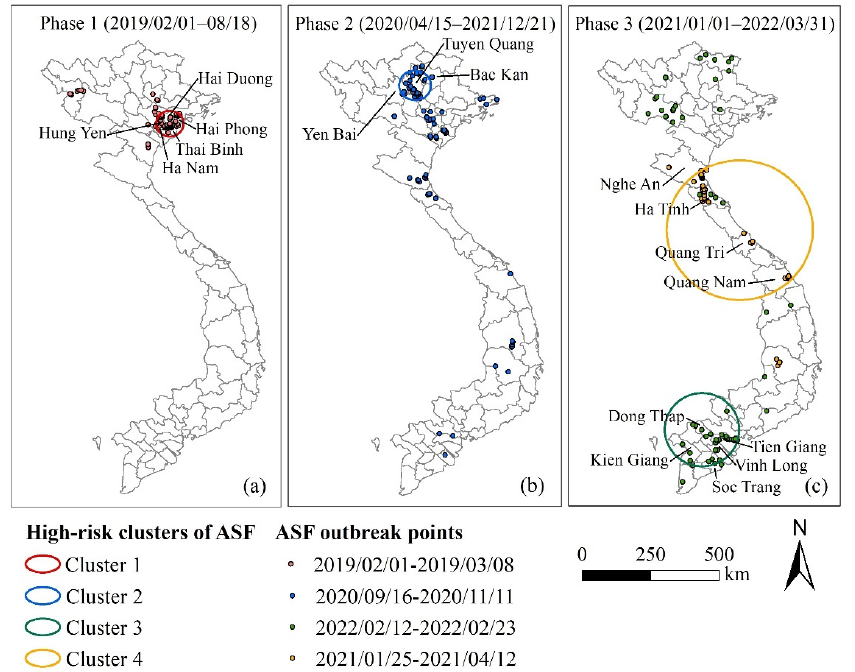
Figure 5. Map of spatiotemporal high-risk clusters of the ASF in Vietnam (February 2019–March 2022).